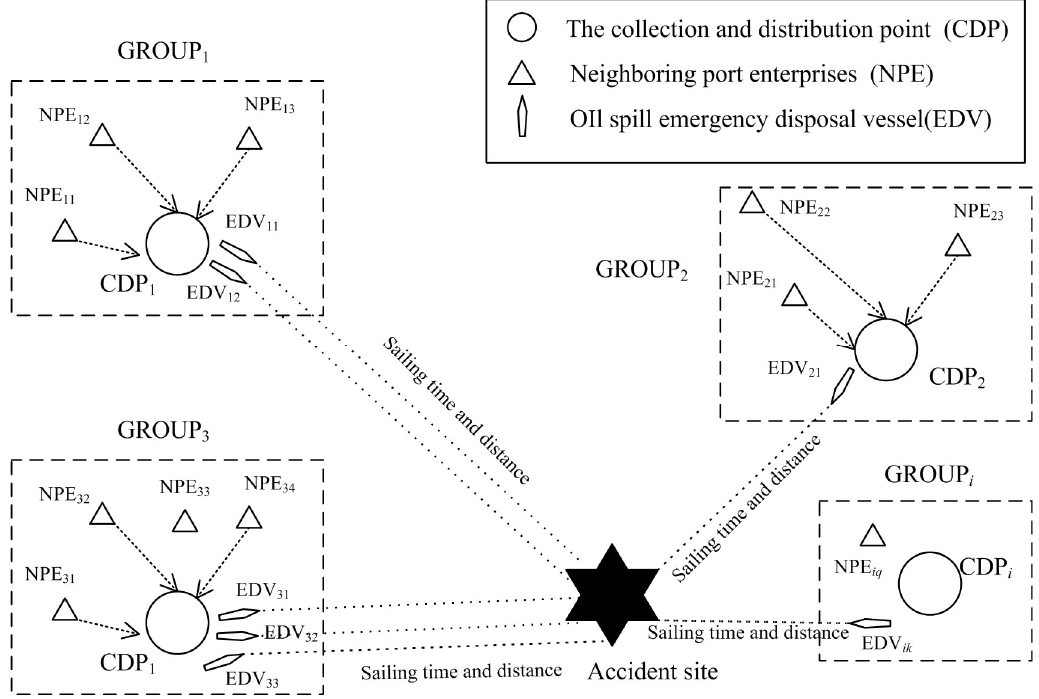
Figure 1. Sketch map of the emergency materials dispatching